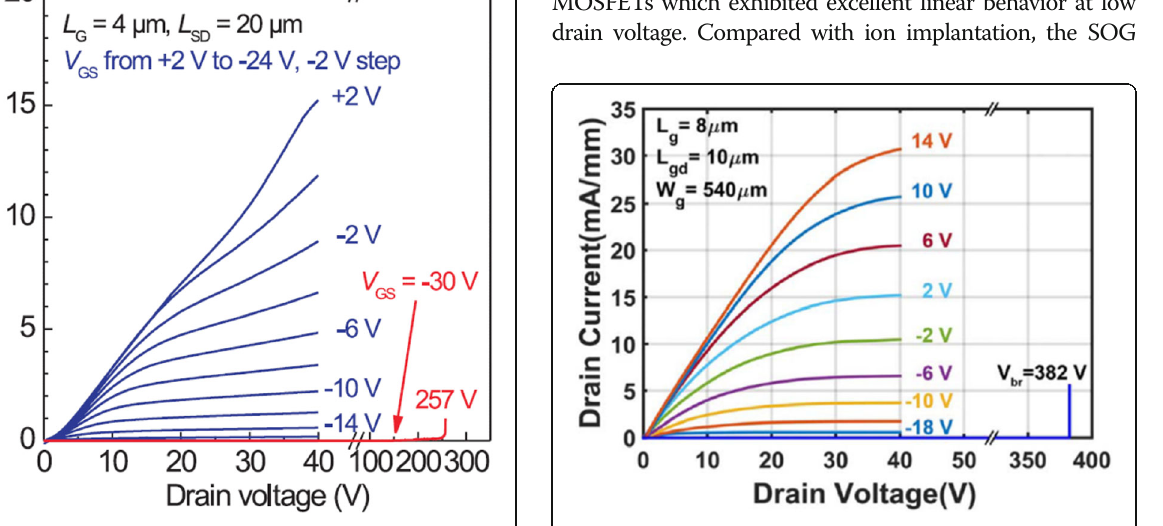
Fig. 4 (Color online) DC output characteristics of Ga 2 O 3 metal/ semiconductor field-effect transistors. Reproduced from Ref. [1]